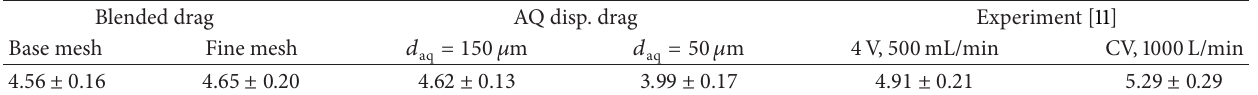
Table 1: Liquid height oscillation frequency (cycles/s) at 3600RPM.